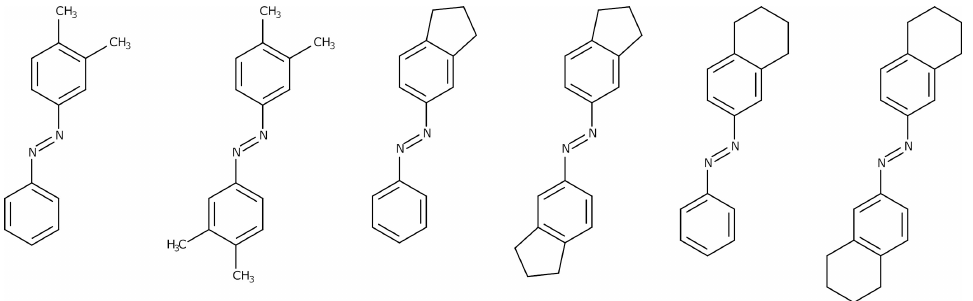
Figure 6. Predicted structures of efficient optical switches for lipid membranes. Table 6. Characteristics of predicted optical switches (depicted in Figure 6) in cis and trans